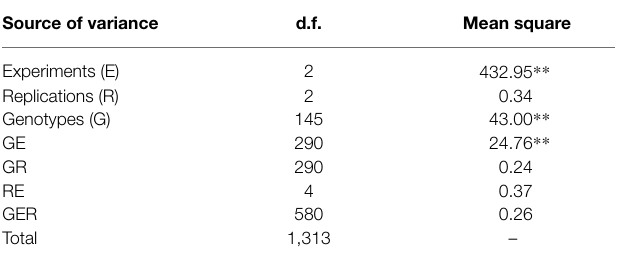
TABLE 1 | Mean square of leaf rust seedling resistance in 198 spring wheat core collection among the three experiments (Exp.S.I., Exp.S.II., and Exp.A.). Source of variance